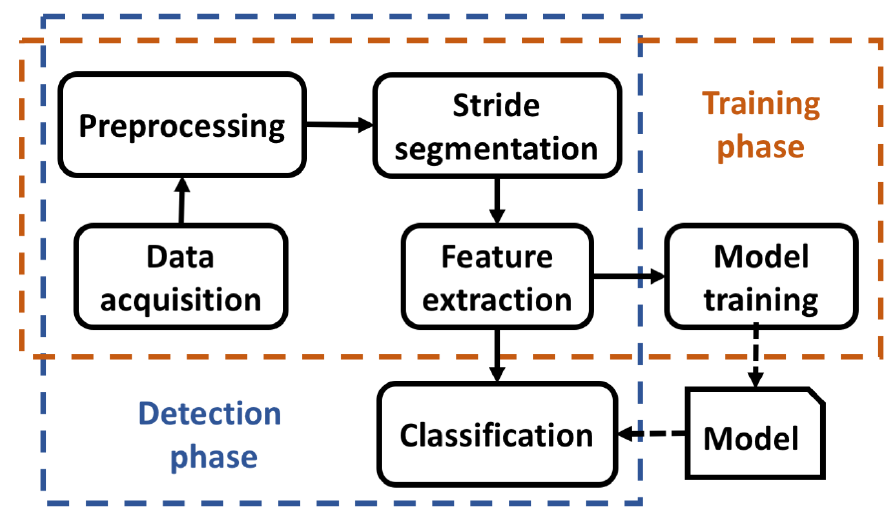
Figure 3. Overview of the Training and Detection phases. The features extracted are used during the training phase to train a machine learning model which is used in the detection phase to classify new feature vectors.